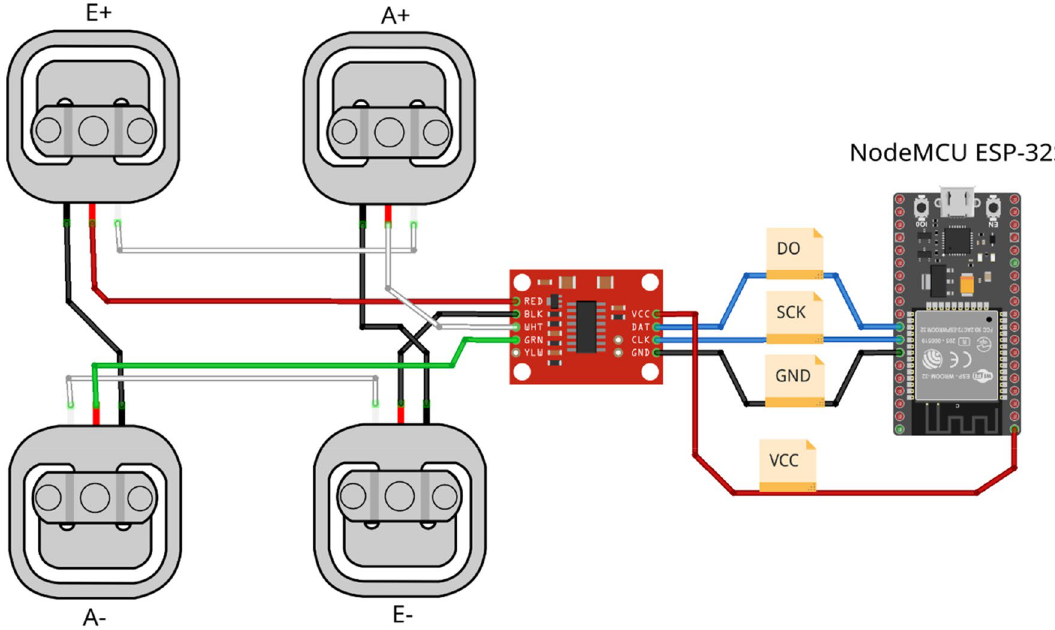
Figure 2. A schematic drawn in Fritzing 5 representing how the four half-Wheatstone-bridge load cells found in our scale are wired together. They are then connected to their respective pins on the HX711 circuit board . This board communicates with the NodeMCU ESP-32S board through the DO and SCK lines routed to pins 18 and 19, respectively. The NodeMCU ESP-32S board provides power to the HX711 board and sends raw data to the computer over USB. This schematic is available in Supplementary material, as well as a full, annotated schematic made in KiCad.